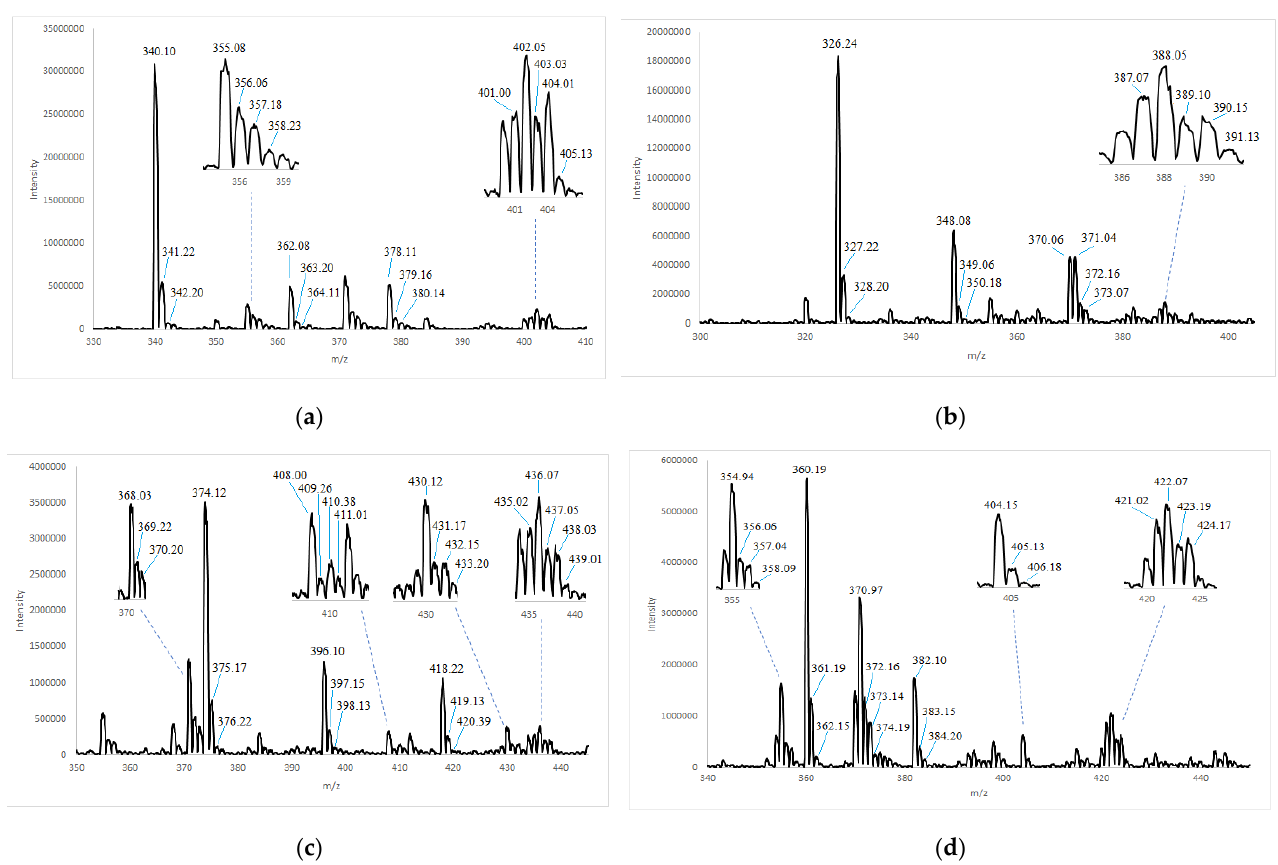
Figure 11. Section of the ESI-MS spectrum (positive mode) for the ( a ) Cu-Sar-LH, ( b ) Cu-GLH, ( c ) Cu-Sar-FH and ( d ) Cu-GFH complexes at a ratio of 1:1 and concentration of 1 mM for Sar-LH, GLH, Sar-FH and GFH, and 0.7 mM for copper(II) in aqueous solution at pH 5. Table 4. Structural assignments of m / z base peaks that were found in the ESI-MS spectrum for Cu- Sar-LH at pH 5 (positive mode) with a 1:1 ratio and concentration of 1 mM for Sar-LH and 0.7 mM for copper(II) in aqueous solution. Complex m / z Assignment 340.10 (LH + H) 1+